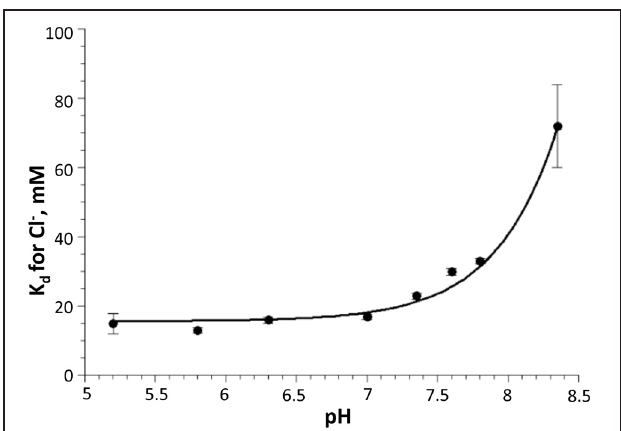
FIGURE 3 | Dependency of Cl − dissociation constant K d on pH for H148G/V224L mutant. Note the relatively small variations of K d in the physiological pH range (7.0–7.5). Data are represented as mean ± SD from 3 independent measurements.